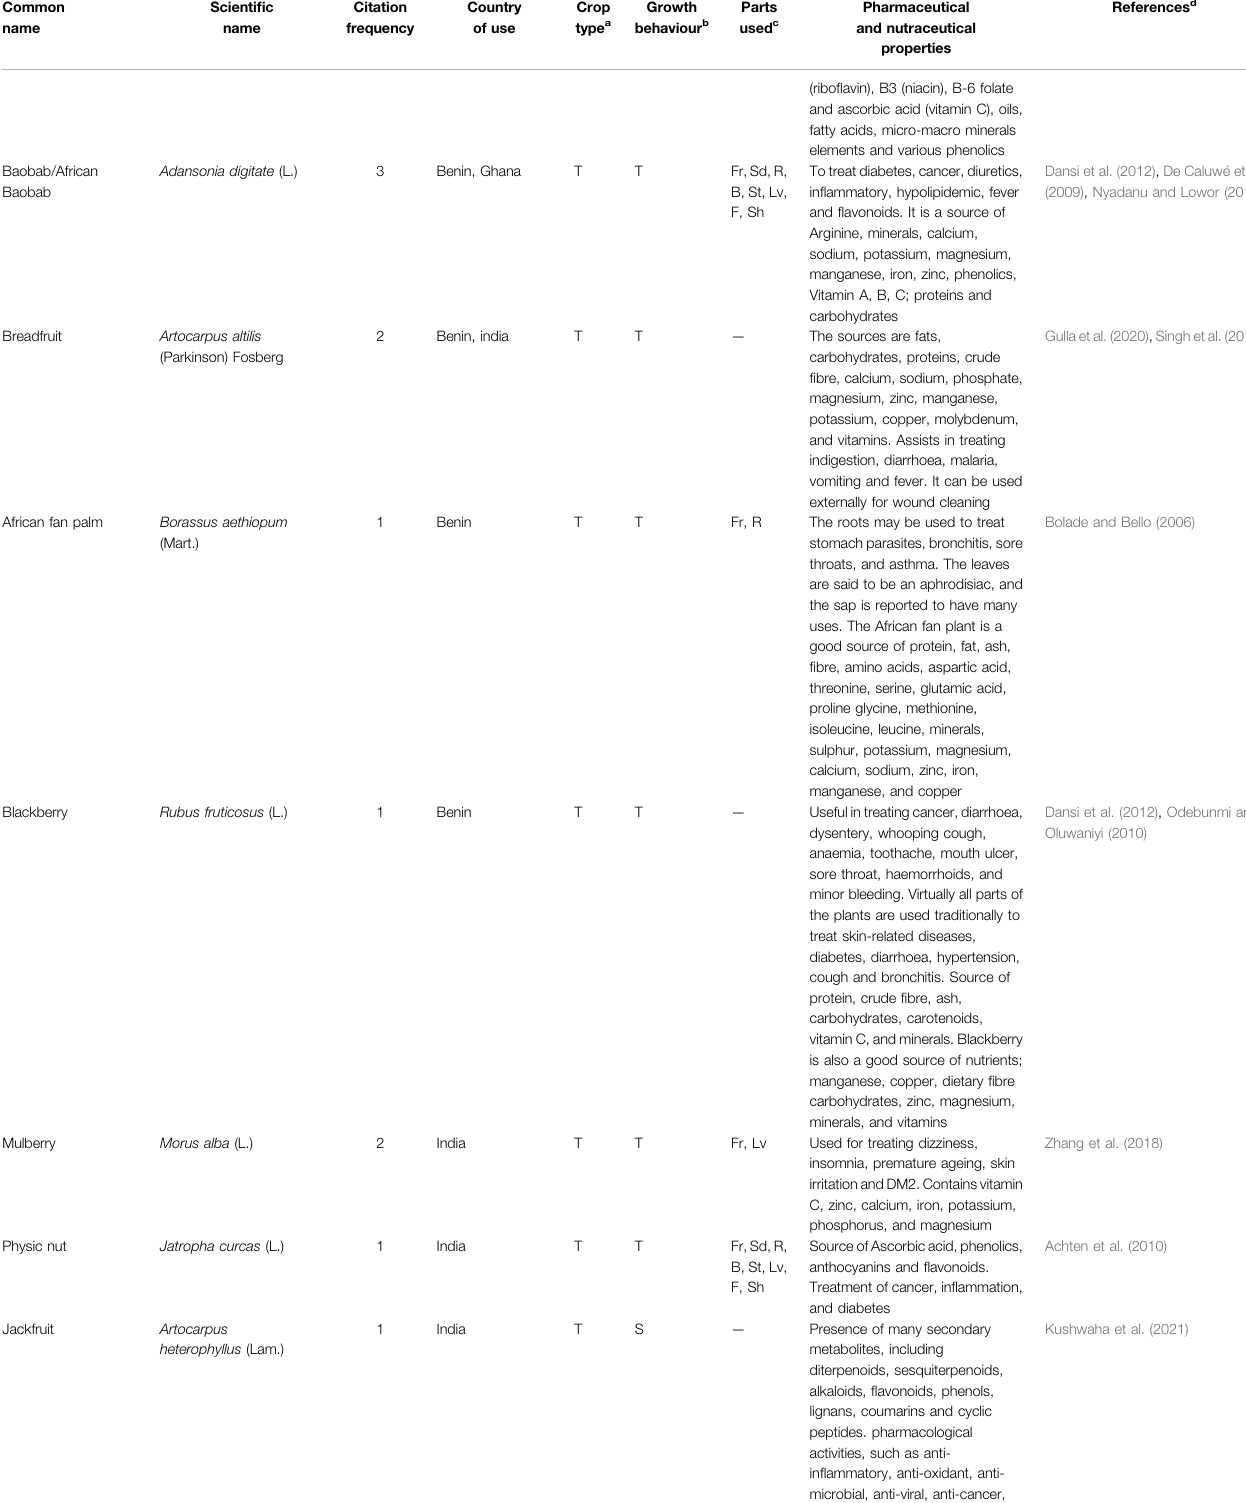
TABLE 1 | ( Continued ) Results of neglected functional medicinal crop species from the systematic review. 1 Crop type -Legume (L), Herb (H), Cereal (C), Cucurbit (Cu), Root and tuber (RT), Tree (T), Shrub (S), Leafy vegetable (LV), Pseudocereal (P) 2 Growth behaviour - Herb (H), Creeper (Cr), Climber (Cl), Tree (T), Shrub (S), 3